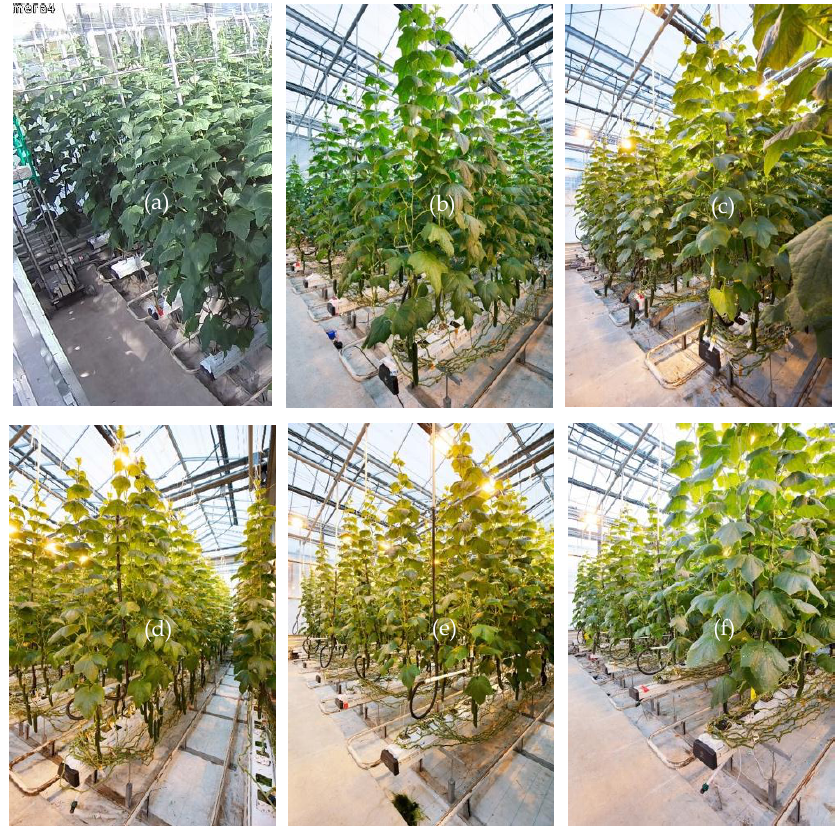
Figure A2. Cucumber crop after 1 month, pictures of different compartments of teams: ( a ) iGrow; ( b ) deep_greens; ( c ) AiCU; ( d ) Sonoma; ( e ) Reference; ( f ) The Croperators.